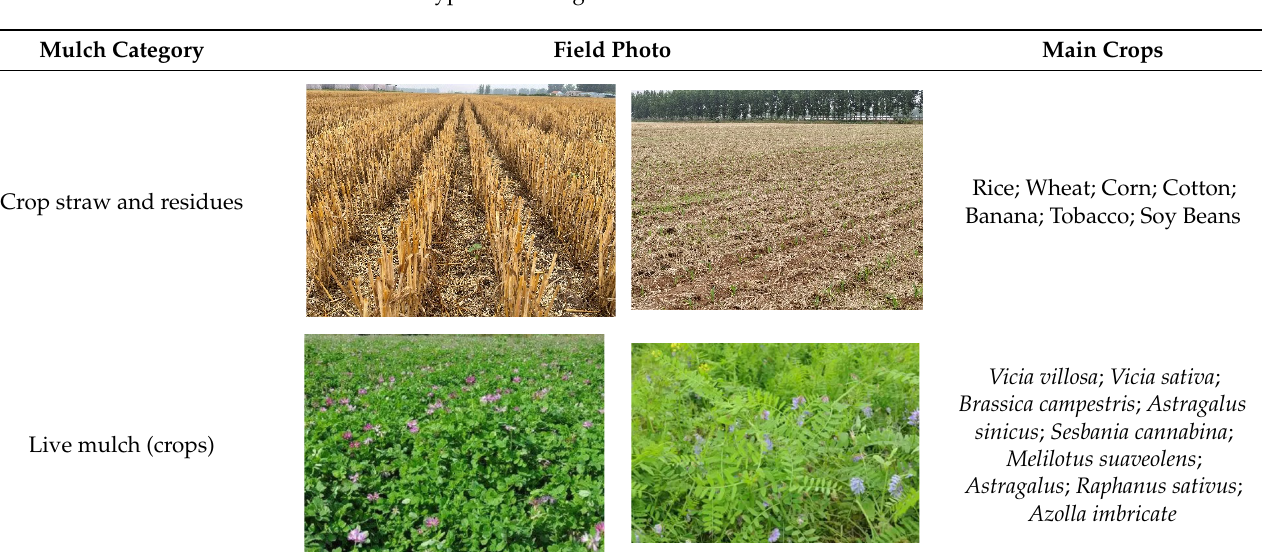
Figure 1. Effect of soil organic cover on SOC content. ( a ) Test method and material; ( b ) results of SOC content in different areas. Table 2. Main types of soil organic mulch in China.